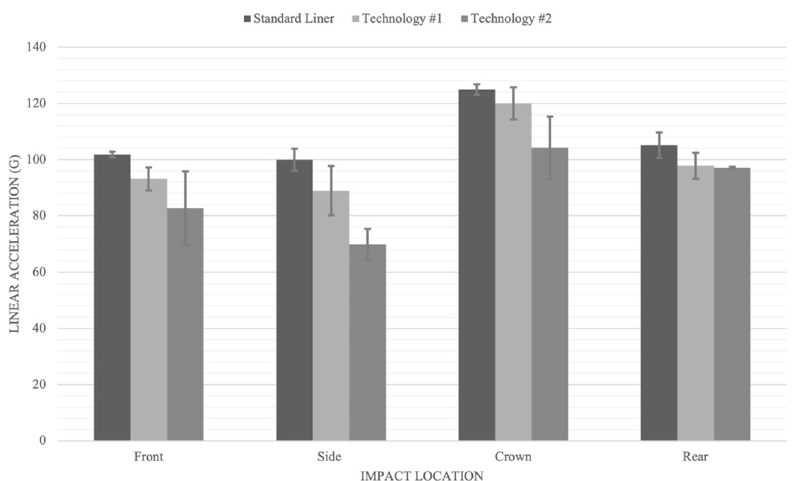
Figure 4. Bar graph displaying peak linear acceleration results in g for impact location and helmet